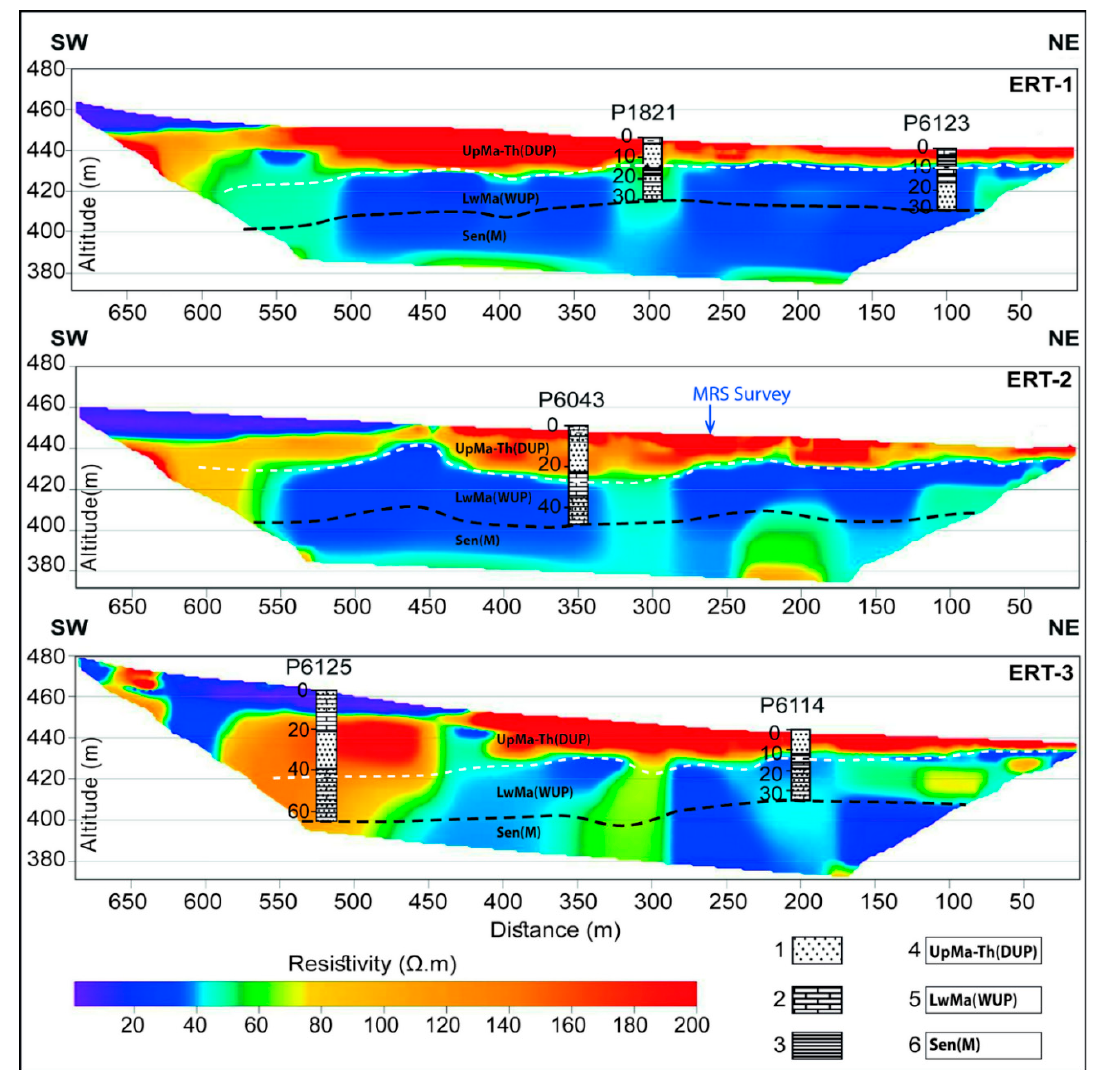
Figure 4. Model resulting from ERT data inversion calibrated to lithological boreholes columns. The dashed white line corresponds to the piezometric level measured on site. The dashed black line indicates the limit between the Maastrichtian and the Senonian formations. 1: Uncemented phosphate; 2: Limestone; 3: Clay; 4: Upper Maastrichtian–Thanetian (dry uncemented phosphate); 5: Lower Maastrichtian: (wet uncemented phosphate); 6: Senonian: (marl).